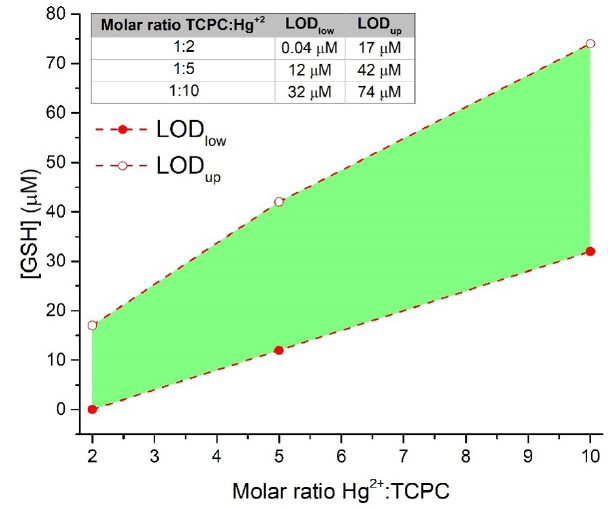
Figure 6. Variation of the LOD low and LOD up again the molar ratio of Hg 2+ -TCPC. The green region represents the determination range. Inset: Table of values of LOD low and LOD up in µ M for the different ratios.